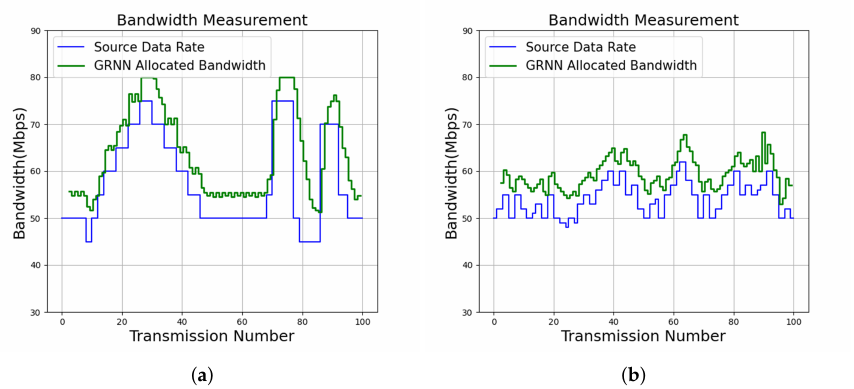
Figure 13. Bandwidth allocation results of the proposed algorithm with T = 8 for various services. ( a ) Proposed GRNN for Service 1; ( b ) Proposed GRNN for Service